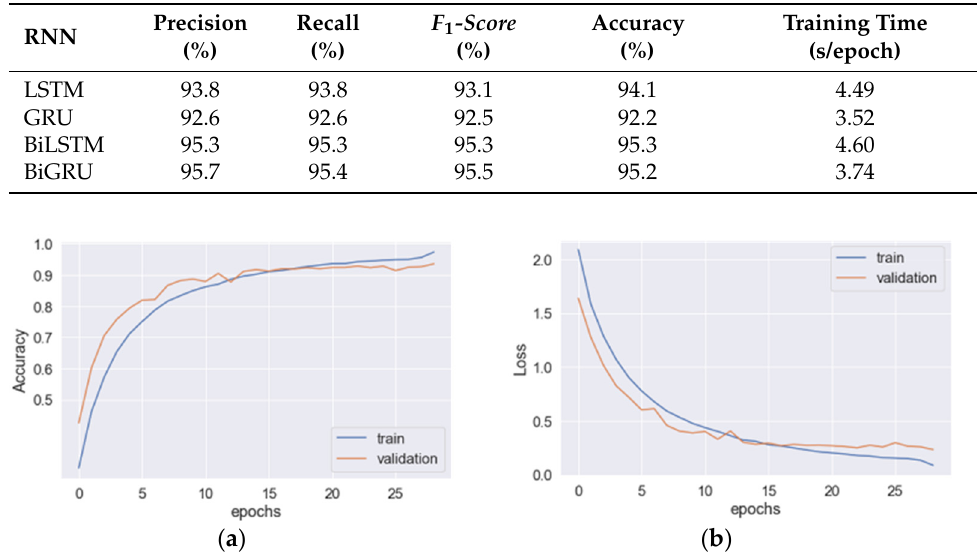
Figure 3. The learning curves for the hybrid CNN+LSTM model: ( a ) the accuracy and ( b ) loss curves.